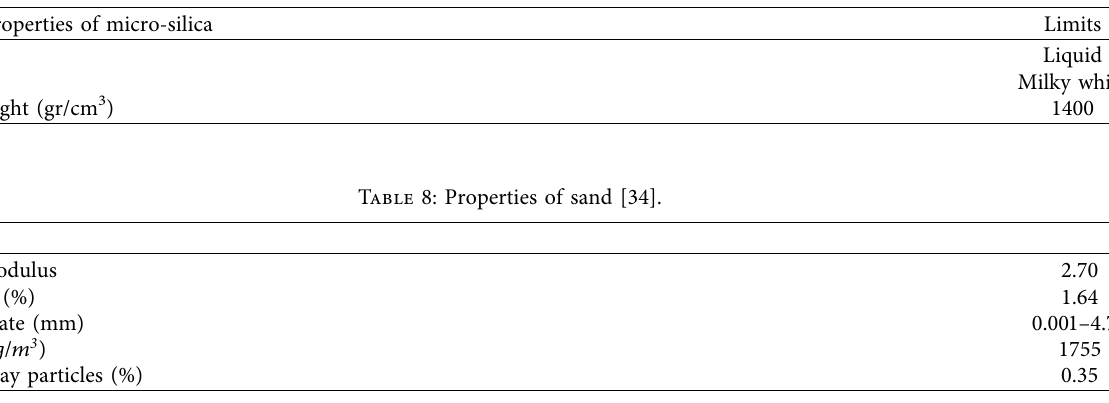
Table 7: Physical properties of micro-silica [41].